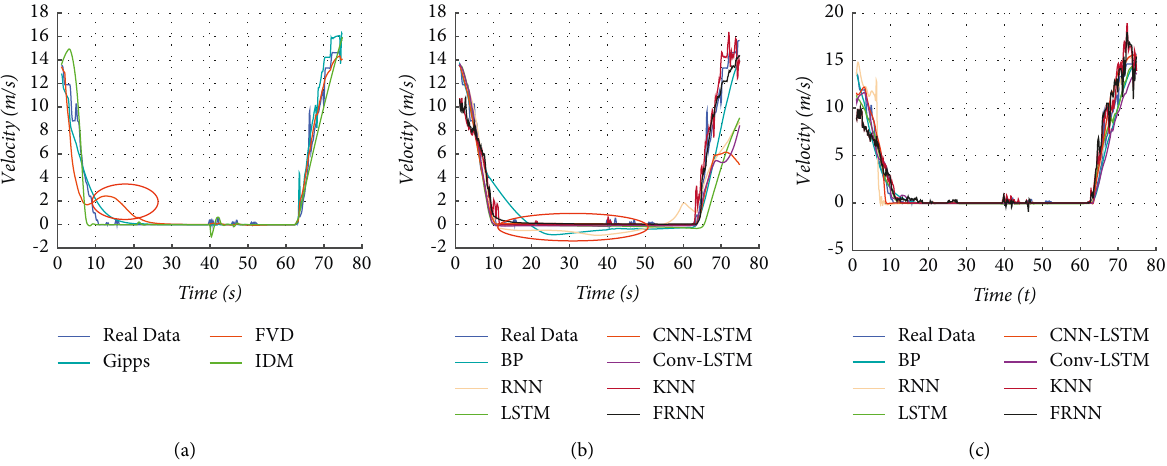
Figure 17: Velocity comparison of discontinuous traffic flow. (a) Conventional models; (b) ANN CF-A; and (c) ANN CF-V